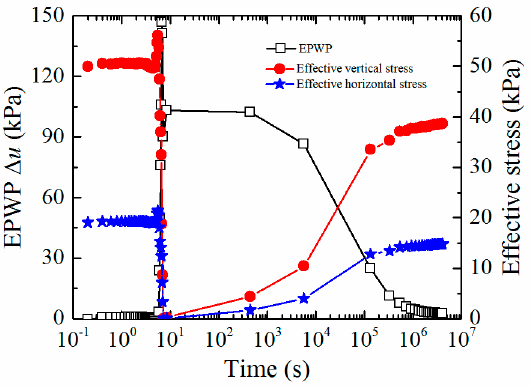
Figure 21. Time histories of the EPWP and effective stress of soil at depth of 7.5 m at z p = 7.8 m.